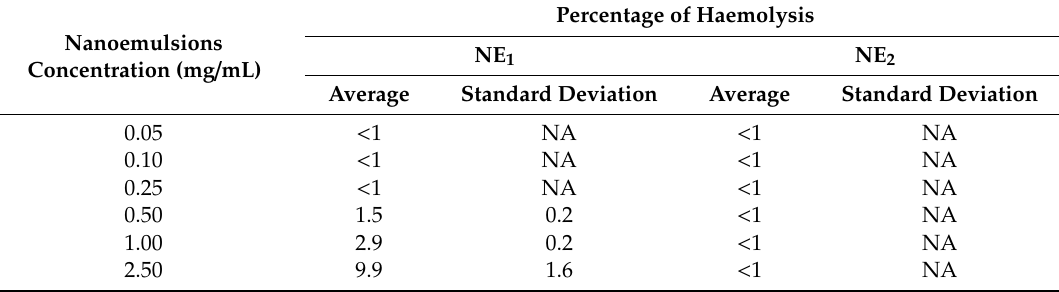
Figure 6. Stability of NE 1 ( a ) and NE 2 ( b ) at 37 ◦ C in PBS estimated by the Z-average ( • ) and the PDI ( ) evolution for 24 h. (cid:35) Table 4. Results of haemolysis test for NE 1 and NE 2